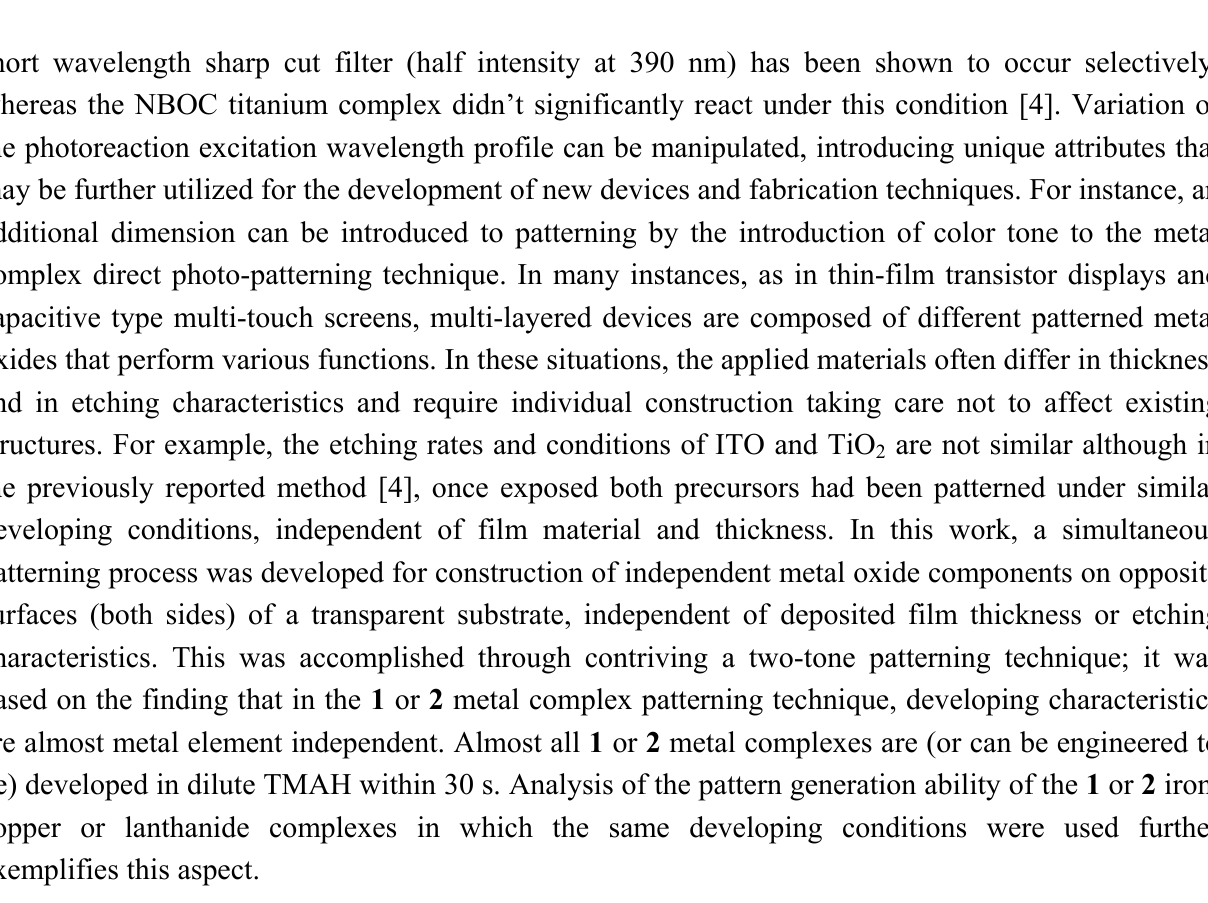
Figure 2. UV-Vis spectra the free ligands 1 (NBOC) and 2 (NVOC). Where NBOC is 4-(2-nitrobenzyloxycarbonyl)catechol, NVOC is